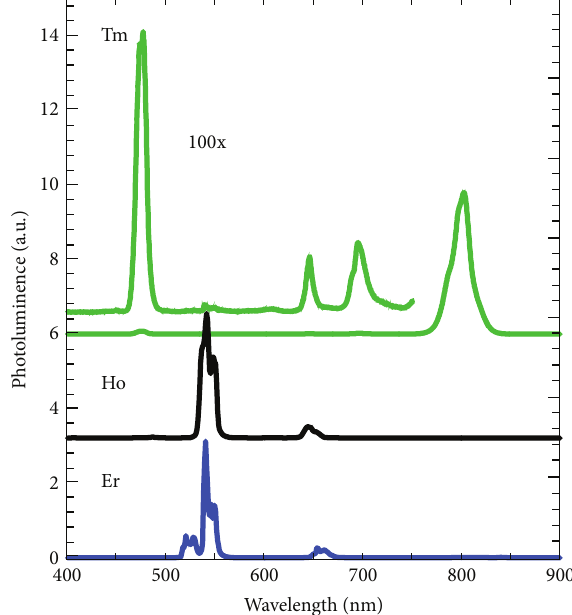
Figure 2: Upconversion spectra for NaYF 4 nanoparticles doped with Yb 3+ as the sensitizer and different lanthanide activator ions: Tm 3+ , Ho 3+ , and Er 3+ , respectively, for curves from top to bottom. The infrared excitation light was from a 975 nm diode laser.